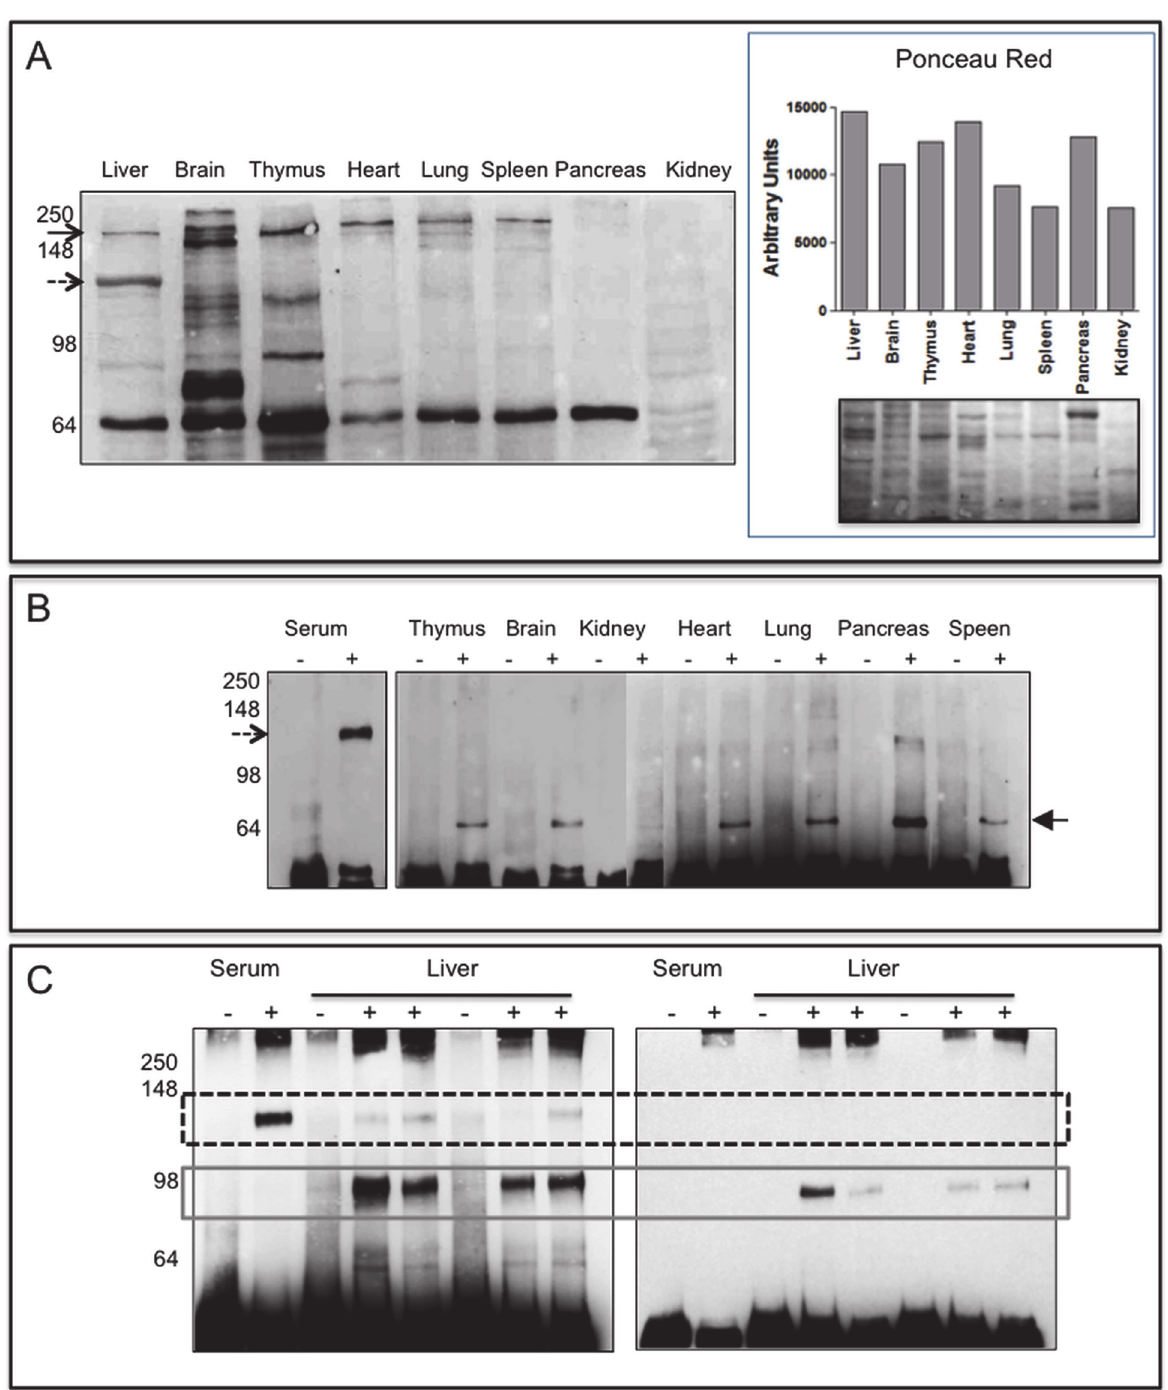
Fig 4. PTPRG expression in murine tissues. Panel A (left): 20 μ g of lysates from perfused tissues were loaded on 10% SDS-PAGE, separated by gel electrophoresis and then blotted onto a PVDF membrane successively incubated with Rb anti-P4 antibody. Black arrow: full-length protein, dashed arrow highlights the 120 kDa protein detectable in liver lysates. On the right it is reported the densitometric analysis of the same samples stained with Ponceau Red and the corresponding image. Panel B : Immunoblotting reacted with Rb anti-P4 antibody of immunoprecipitated (IP) murine serum and tissue lysates (IP from 250 μ g of tissue lysates). Lanes-: IP with Protein G Sepharose rabbit IgG isotype control. Lanes +: IP Protein G Sepharose Rb anti-P4. Dashed arrow: * 120 kDa isoform, black filled arrow: * 70 kDa isoform, maybe an intracellular, immature form of a soluble protein, or of a fragment of the full-length protein also present in Panel A. Lack of detectable amounts of full length protein is likely associated to residual proteolysis occurring during the IP step. Panel C: Immunoprecipitation from mouse serum and liver lysates performed with anti P4 antibody (+) or with RbIgG isotype (-). Left: WB performed with Rb anti-P4